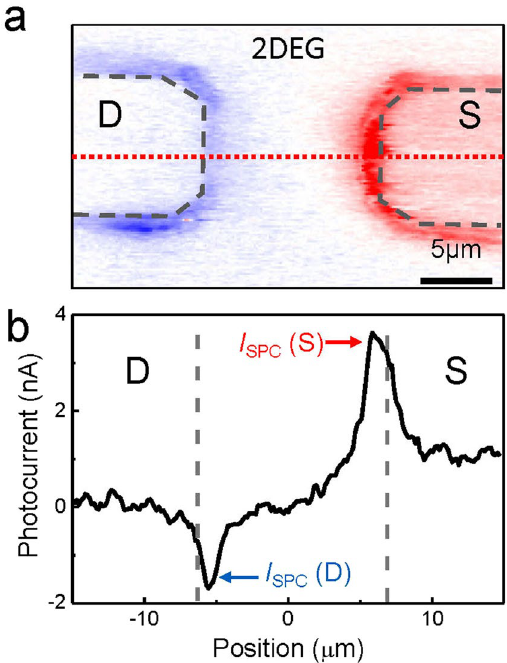
Figure 3. ( a ) A SPCM image of 2DEG device taken at V SD = V G = 0. Red (blue) indicates positive (negative) current. ( b ) Photocurrent profile as a function of position, extracted from ( a ) along the red dotted